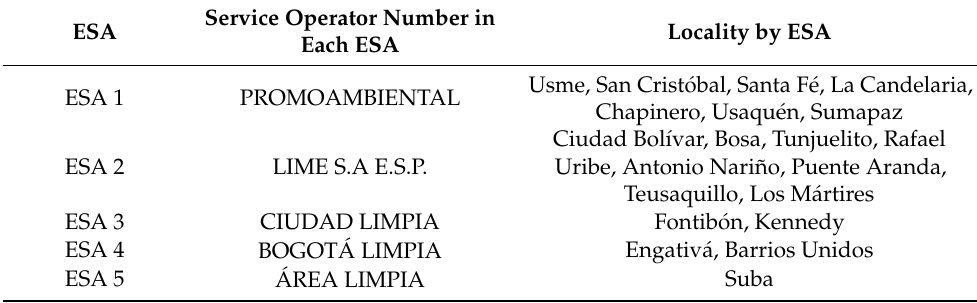
Figure 4. Household trash collection service providers in Bogotá [63]. Table 1. Structure of the ESAs for the collection of solid waste in Bogotá [62]. Table 1. Structure of the ESAs for the collection of solid waste in Bogot á